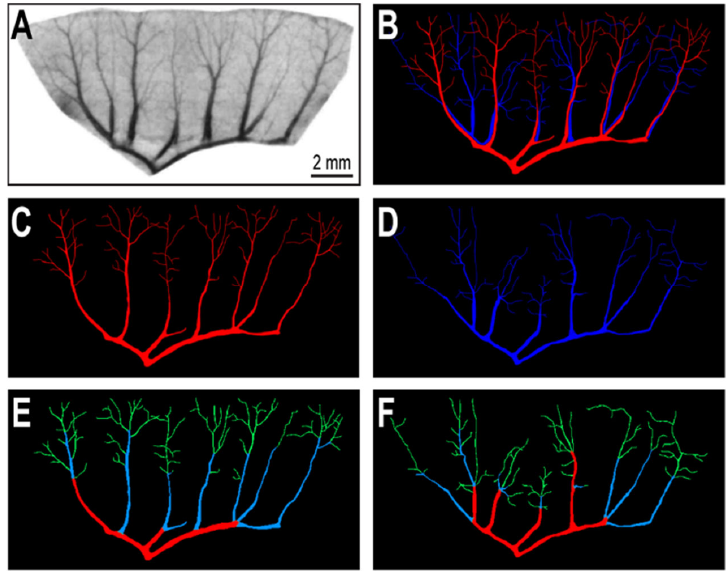
Figure 1. Preparation and analysis of rat vascular mesenteric images . ( A ) The background-inverted fluorescence image (from [27]). ( B ) This image was segmented and separated into the arterial (red) and venular (blue) components. ( C ) Separated arterial pattern. ( D ) Separated venous pattern. ( E ) VESGEN 2D assignment of branching in the arterial patterns to three generations. ( F ) Similar assignment of the venous pattern branches to three generations. Bar: 2 mm for all images.